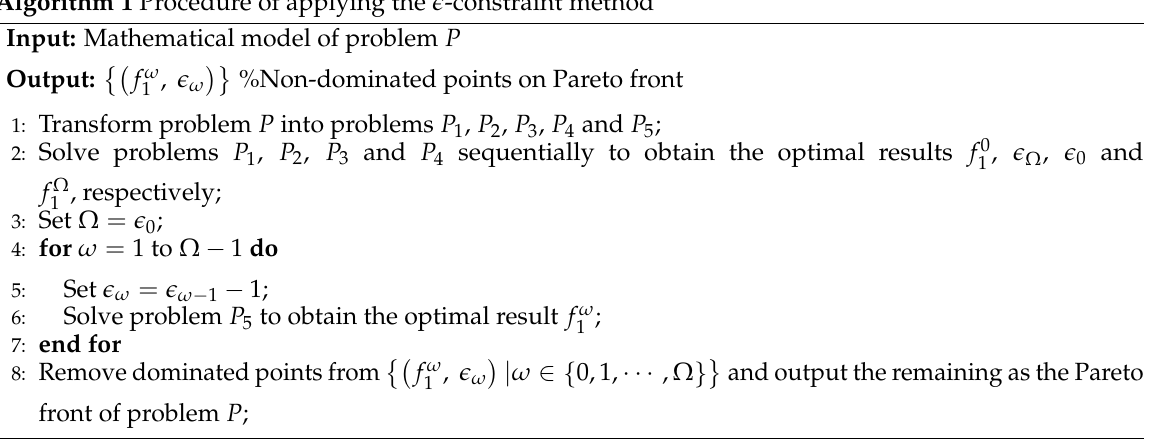
Algorithm 1 Procedure of applying the (cid:101) -constraint method